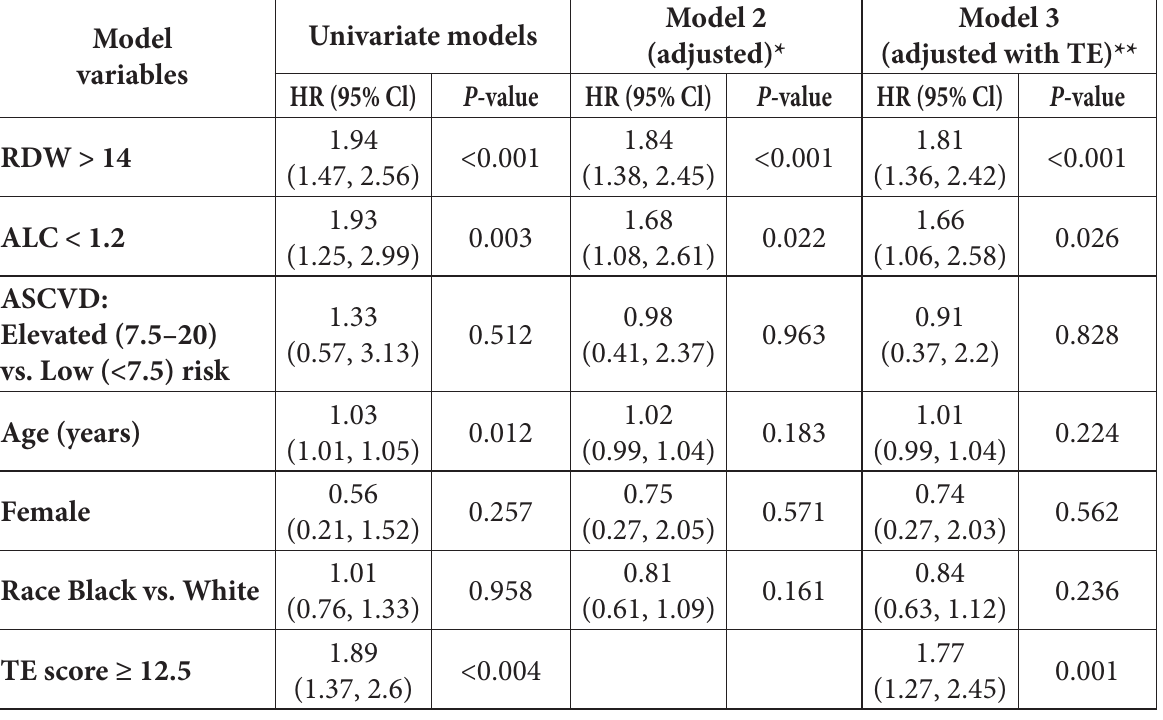
Table 3. Adjusted models for relationship between RDW, ALC, TE, and